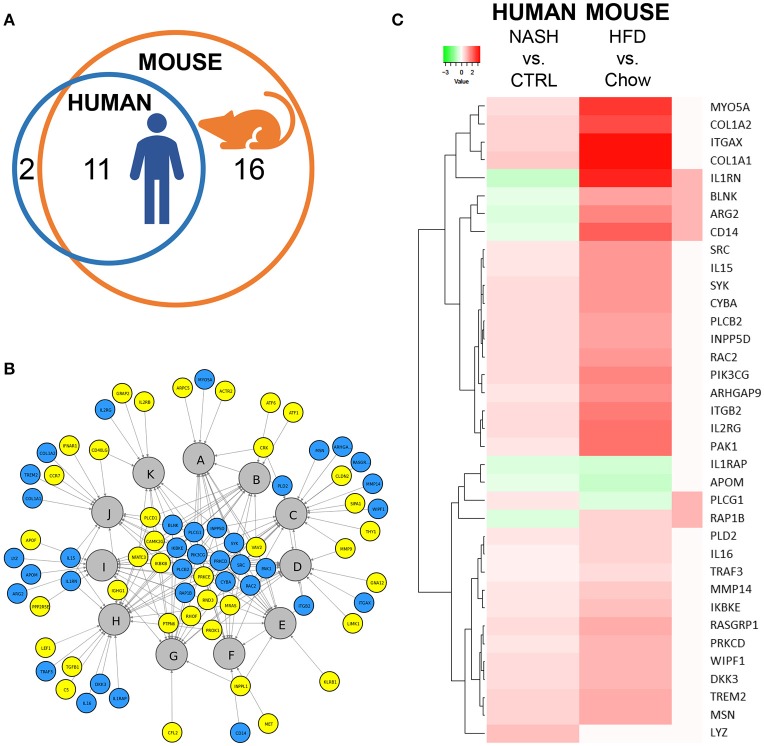
Representation of human key molecular pathways and associated genes in HFD-fed Ldlr−/−.Leiden mice. (A) Venn diagram to visualize the overlap in canonical pathways between human NASH biopsies (red circle) and Ldlr−/−.Leiden mice (blue circle). (B) Network visualization of overlapping canonical pathways (gray nodes, A: Fcγ Receptor-mediated Phagocytosis in Macrophages and Monocytes, B: PI3K Signaling in B Lymphocytes, C: Leukocyte Extravasation Signaling, D: IL-8 Signaling, E: Natural Killer Cell Signaling, F: Macropinocytosis Signaling, G: B Cell Receptor Signaling, H: Role of Macrophages Fibroblasts and Endothelial Cells in Rheumatoid Arthritis, I: Production of Nitric Oxide and Reactive Oxygen Species in Macrophages; J: Dendritic Cell Maturation; K: iCOS-iCOSL Signaling in T Helper Cells) and the associated significantly expressed genes in human NASH (blue and yellow nodes). The blue nodes represent genes that were also regulated in the Ldlr−/−.Leiden mouse, the yellow nodes represent genes that were not significantly regulated in the Ldlr−/−.Leiden mouse. (C) Heatmap visualization of genes underlying the common pathways that are regulated in both human NASH biopsies and HFD-fed Ldlr−/−.Leiden mice relative to their respective controls. Red color indicates upregulated genes and green color indicates downregulated genes. The rightmost column shows the genes that do not share their direction of regulation between human and mouse in red.